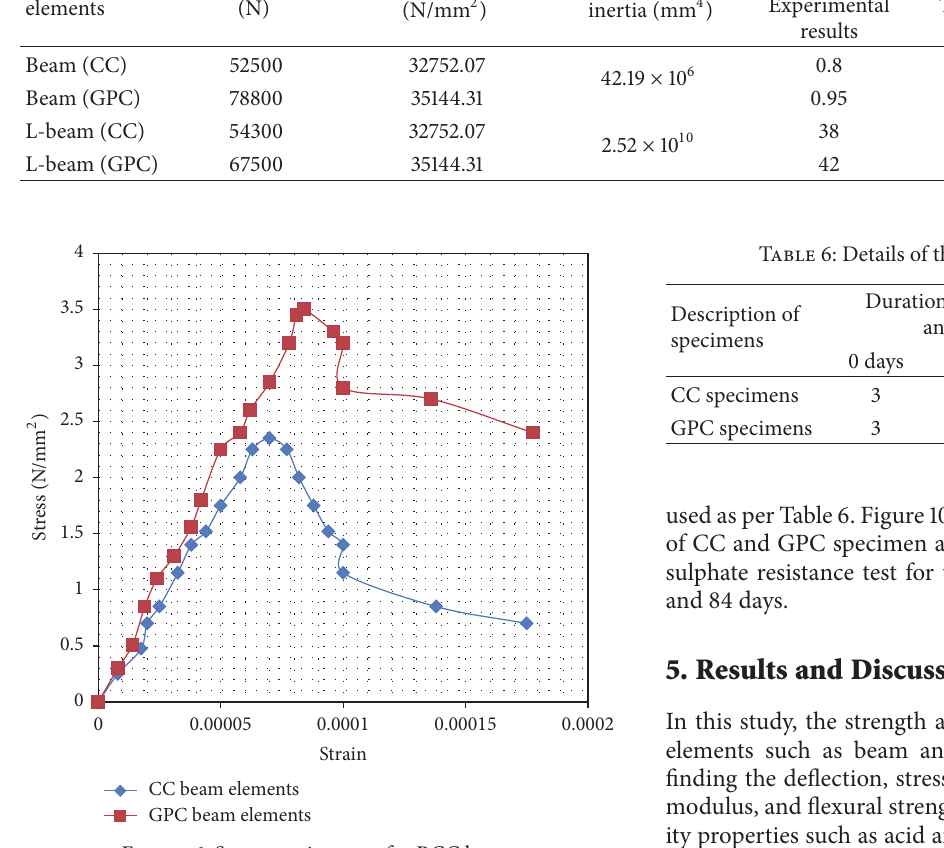
Figure 6: Stress-strain curve for RCC beam.